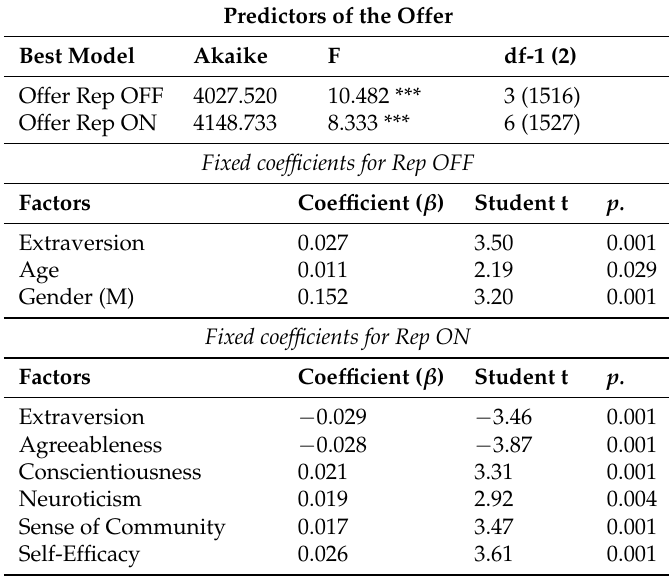
Table 4. GLMM 1. Socio-demographic and Psychological predictors of offer behavior in each condition.